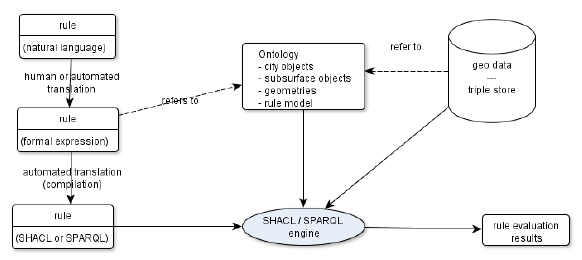
Figure 1. Rule translation and